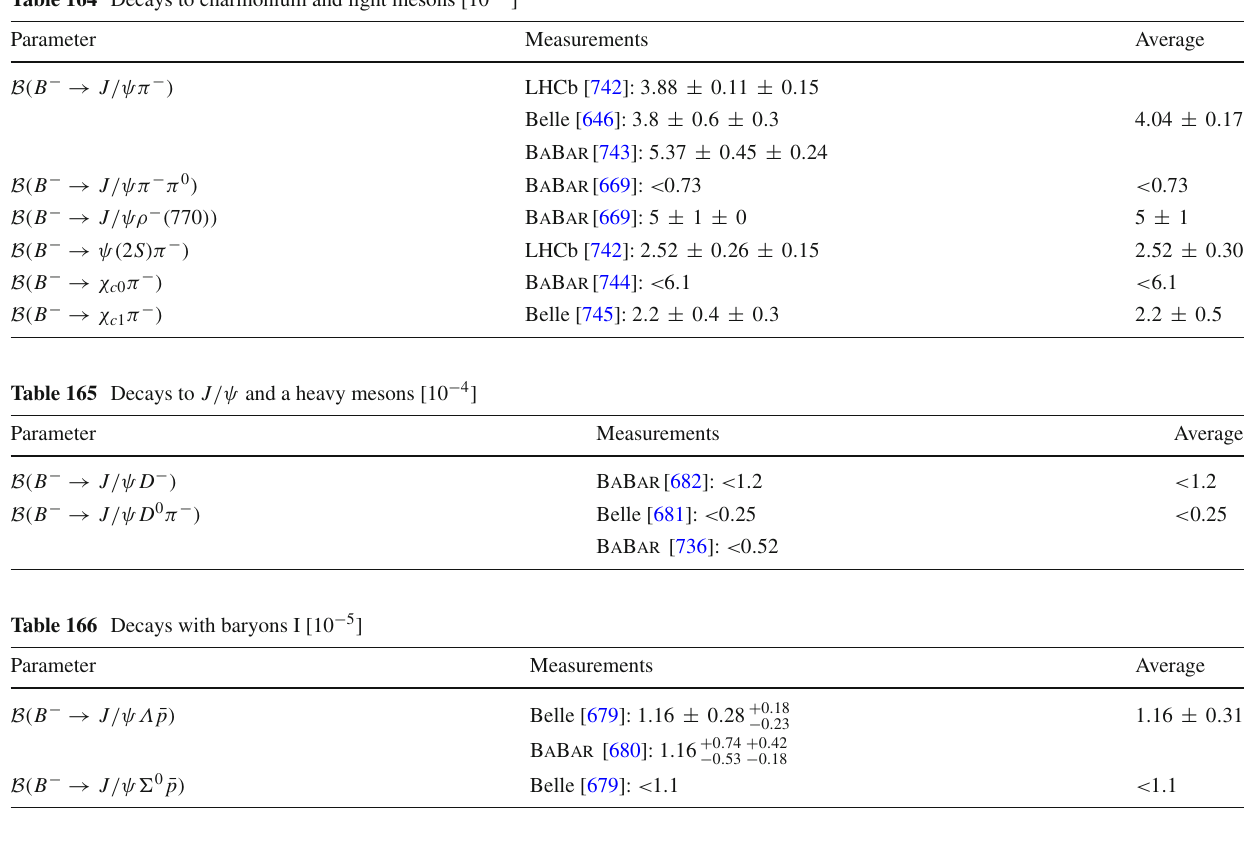
Table 164 Decays to charmonium and light mesons [ 10 − 5 ]